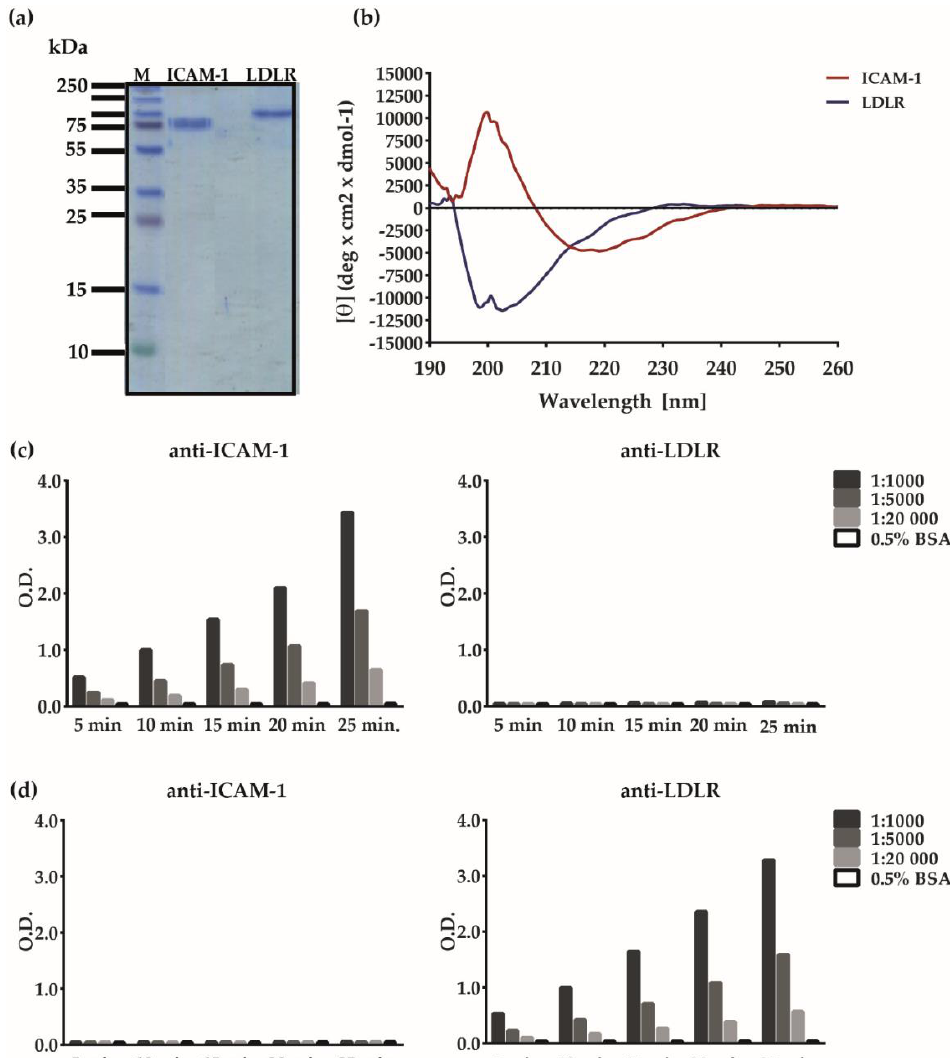
Figure 2. Characterization of recombinant human ICAM-1 and LDLR. ( a ) Coomassie-blue stained SDS-PAGE with recombinant human ICAM-1 (lane 1) and LDLR (lane 2). A molecular-weight marker (kDa) is indicated on the left. ( b ) Mean residue ellipticities ( θ , y -axis) of ICAM-1 (red) and LDLR (blue) recorded at di ff erent wavelengths (nm, x -axis) by circular dichroism (CD) spectroscopy. Detection of ( c ) ICAM-1 or ( d ) LDLR with serial dilutions of anti-ICAM-1 antibodies (c = 1 µ g / mL; left), anti-LDLR antibodies (c = 0.2 µ g / mL; right) or bovine serum albumin (BSA)-containing bu ff er alone (BSA) by ELISA. Shown are means of optical density (O.D.) values corresponding to bound antibodies (y-axes) measured at di ff erent time points (x-axes). The variations of individual duplicate results of ELISAs were less than 5%. The antibody titration in ( c ) and ( d ) was done